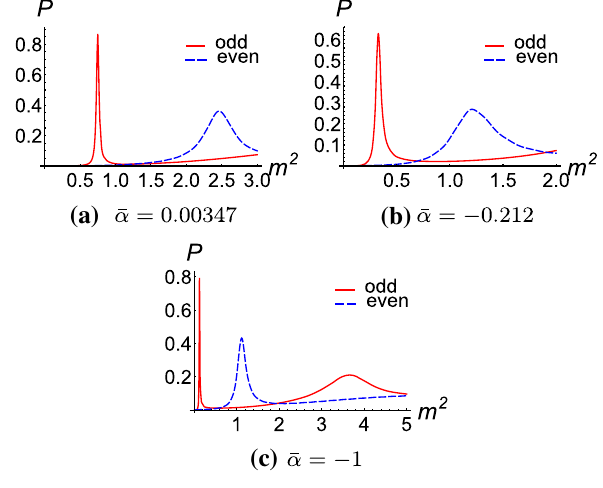
Fig. 7 The relative probabilities for different values of ¯ α for f ( T ) = T + ¯ α T 2 . The parameter is set to ¯ b = 4 k 2